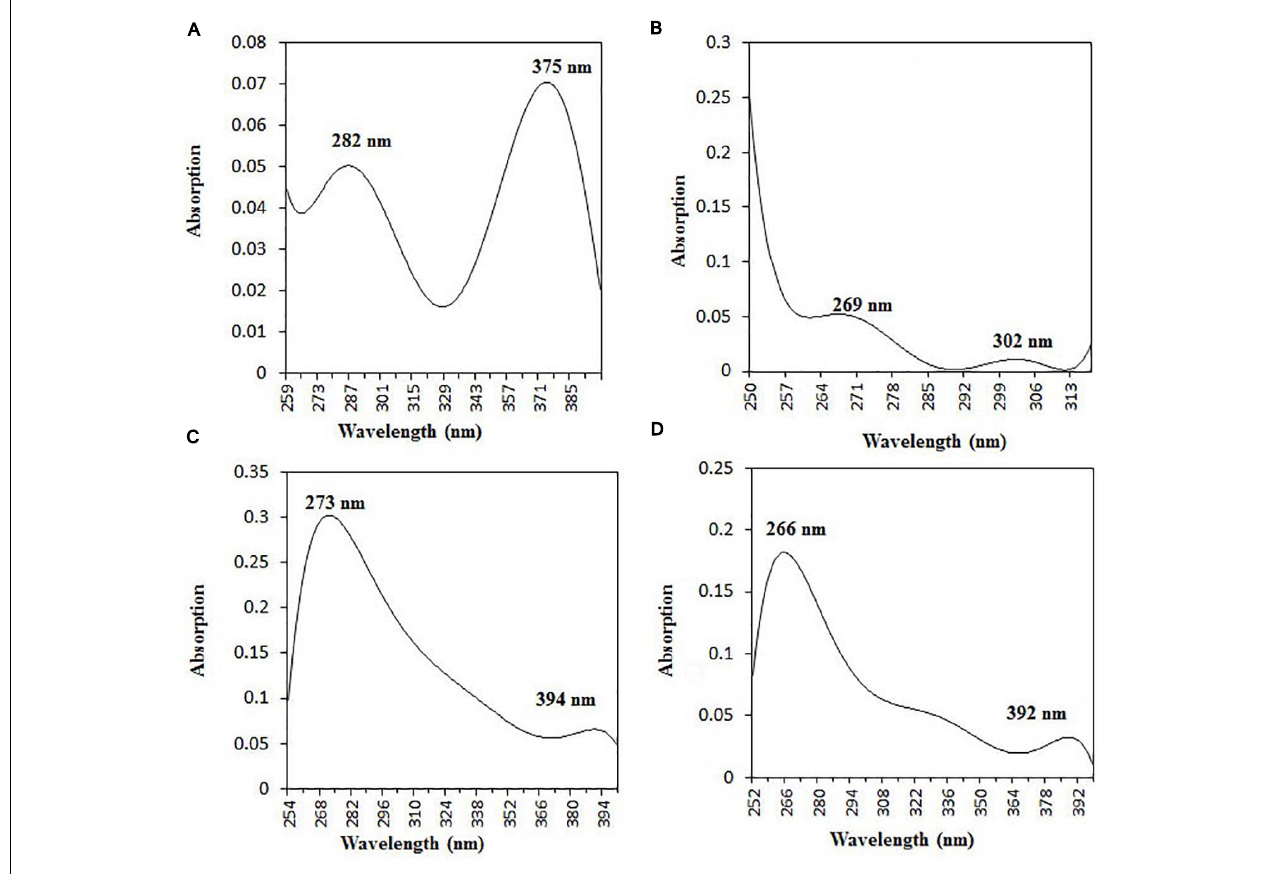
FIGURE 10 | UV–vis absorbance spectra of purified bioactive fractions from B. petrensis culture extracts. The UV–visible spectrum of bioactive fraction showed two main absorption peaks at λ 282 and λ 375 for C2 (A) , λ 269 and λ 302 for C5 (B) , λ 273 and λ 394 for M3 (C) , and λ 266 and λ 392 for M4 (D)